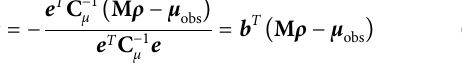
Frontiers in Earth Science |